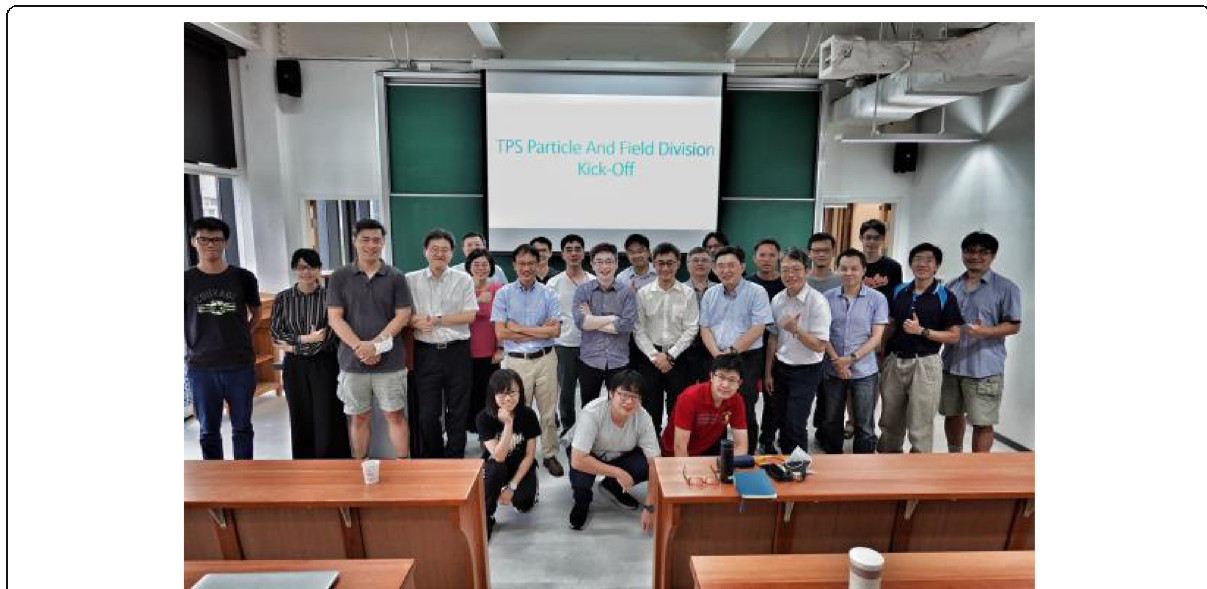
Fig. 6 The inaugurating meeting of the first division (the Division of Particle and Field) at National Taiwan University on September 9, 2020